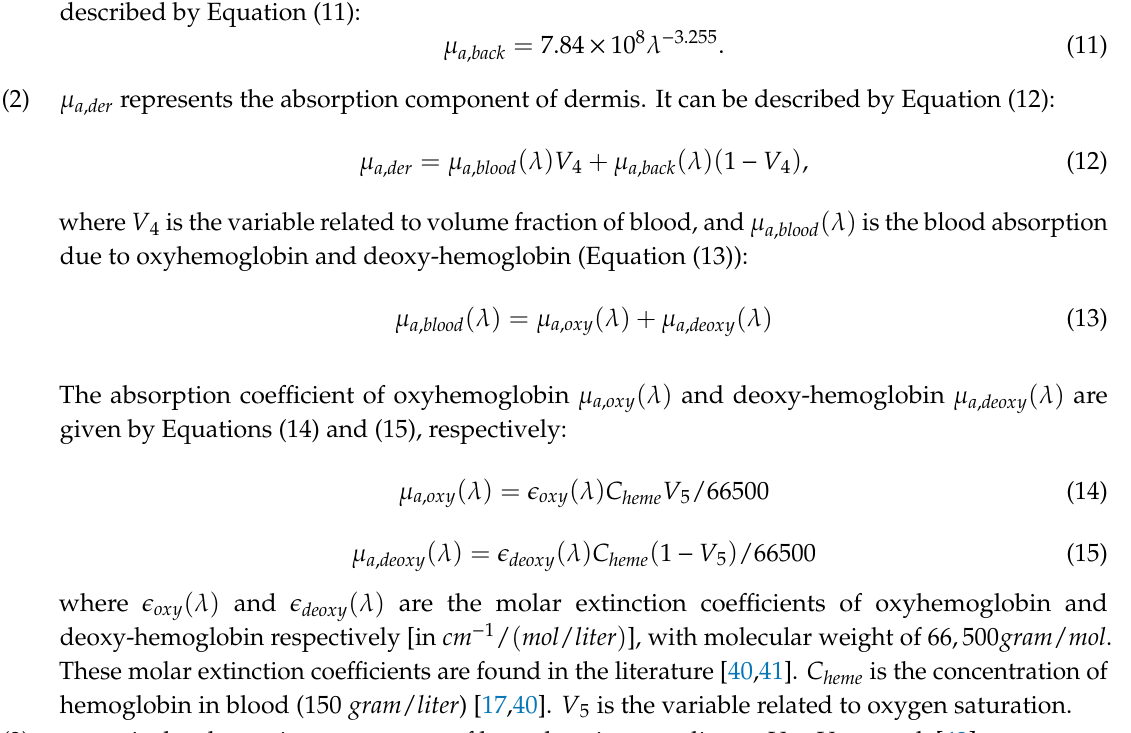
Table 1. Absorption parameters in human skin and related variable in the hamster skin’s direct model. Range Value in Variable in Hamster Biological Parameter Skin Layer Reference Human Skin Skin’s Direct Model Volume Fraction (V.F.) Dermis 0.01–0.43 [16] V 3 Melanosomes [%] Volume Fraction (V.F.) Dermis 0.002–0.07 [16,40] V 4 Hemoglobin [%] Oxygen Saturation [%] Dermis 0–1 [16] V